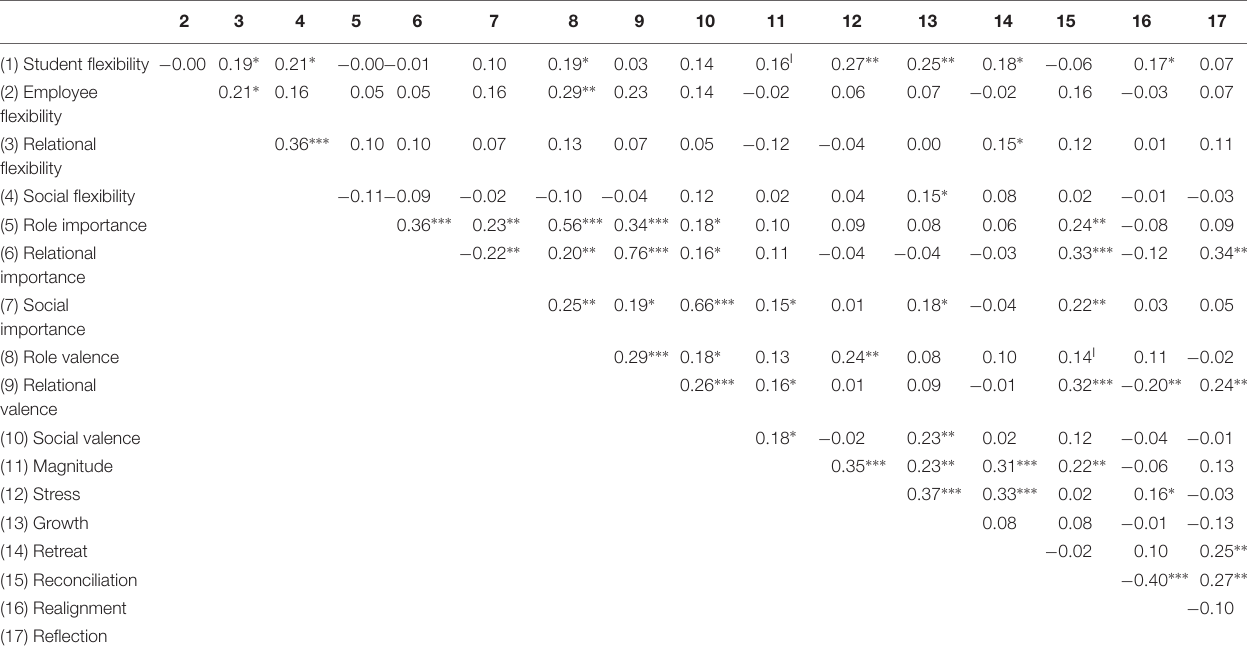
TABLE 4 | Correlations between identity characteristics, and the experience and management of identity conflict (Study